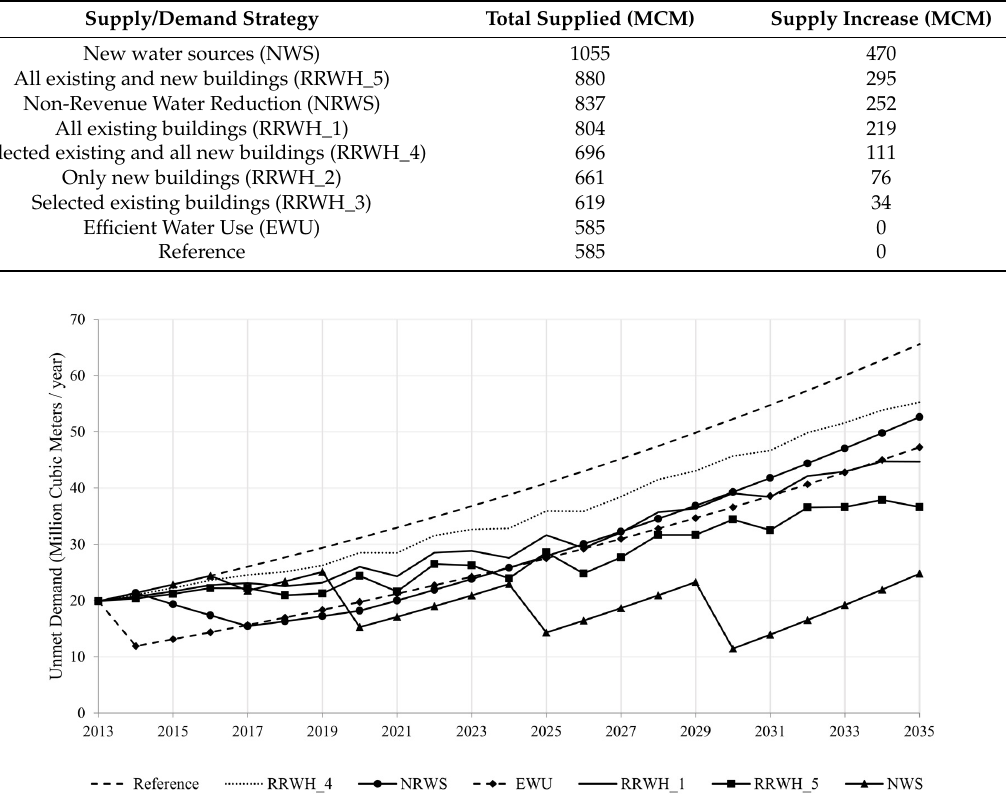
Figure 10. Unmet demand for Mombasa City for different management strategies (see Table 11 for acronym definitions).